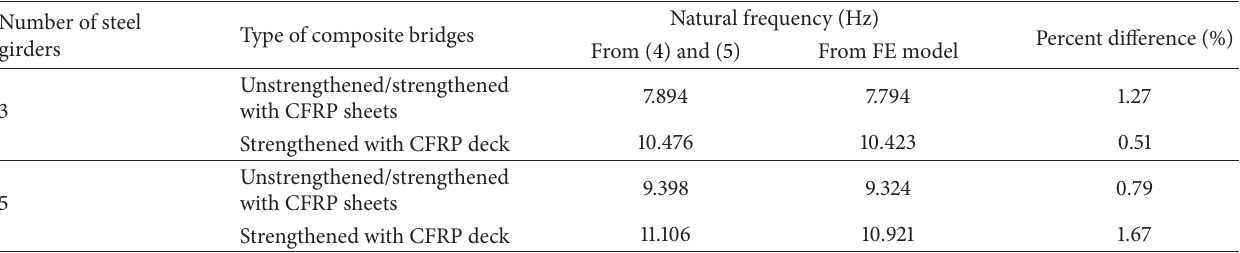
Table 3: A comparison of natural frequency of the bridges.